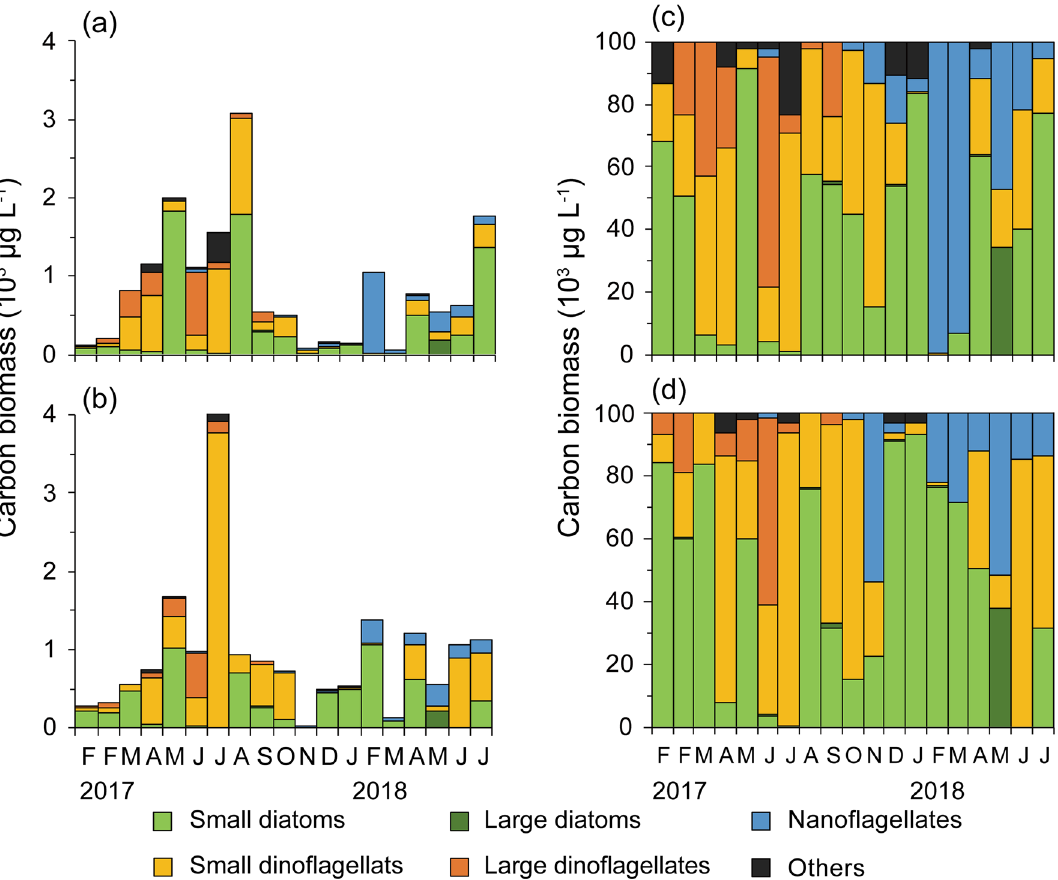
Figure 12. Seasonal variation in phytoplankton carbon biomass at St. F3 ( a ), St. CB ( b ) and composition of carbon biomass at St. F3 ( c ), St. CB ( d ) from February 6, 2017 through June 26, 2018. In 2017, the first F is on February 6, the second F is on February 14.